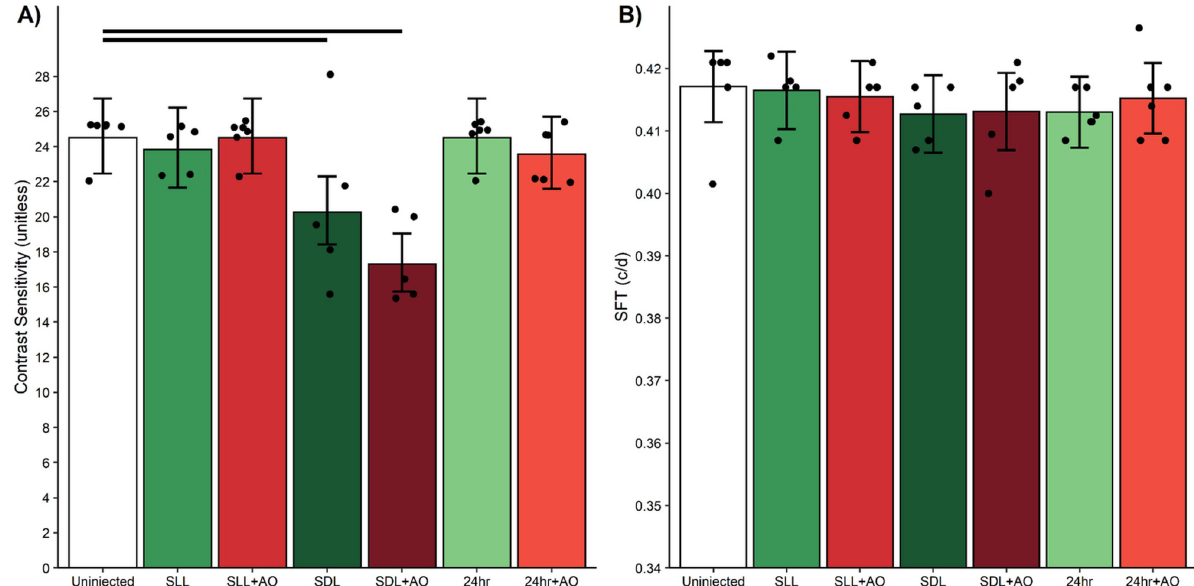
Fig 9. Contrast sensitivity is transiently reduced at 5 hr post-sildenafil. Compared to uninjected 5 hr light adapted mice (white bar), sildenafil + saline (green bars) A) decreased contrast sensitivity only under SDL conditions but B) did not change spatial frequency threshold (SFT). AO (red bars) did not correct this reduced contrast sensitivity. Black horizontal bars indicate significant differences (P < 0.05). The points in each plot represent the estimated mean for each mouse based on the model. Error bars are 95% confidence intervals. Number of mice used per group: uninjected, n = 6 mice; SLL+saline, n = 5 mice; SLL+AO, n = 6 mice; SDL+saline, n = 5 mice; SDL+AO, n = 5 mice; 24 hour+saline, n = 6 mice; 24 hour+AO, n = 6 mice.